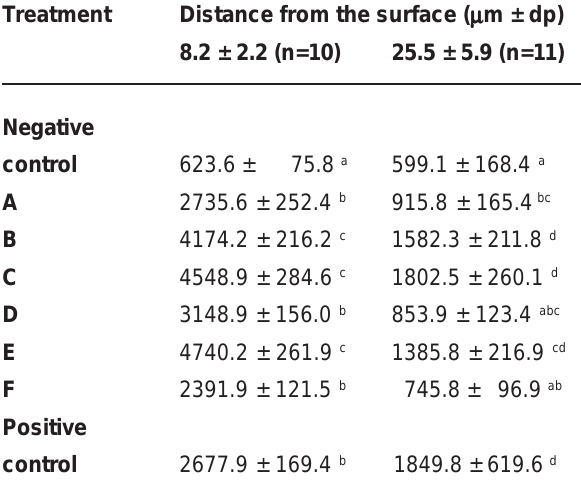
Treatments whose means are followed by different letters differ statistically by the Newman-Keuls test